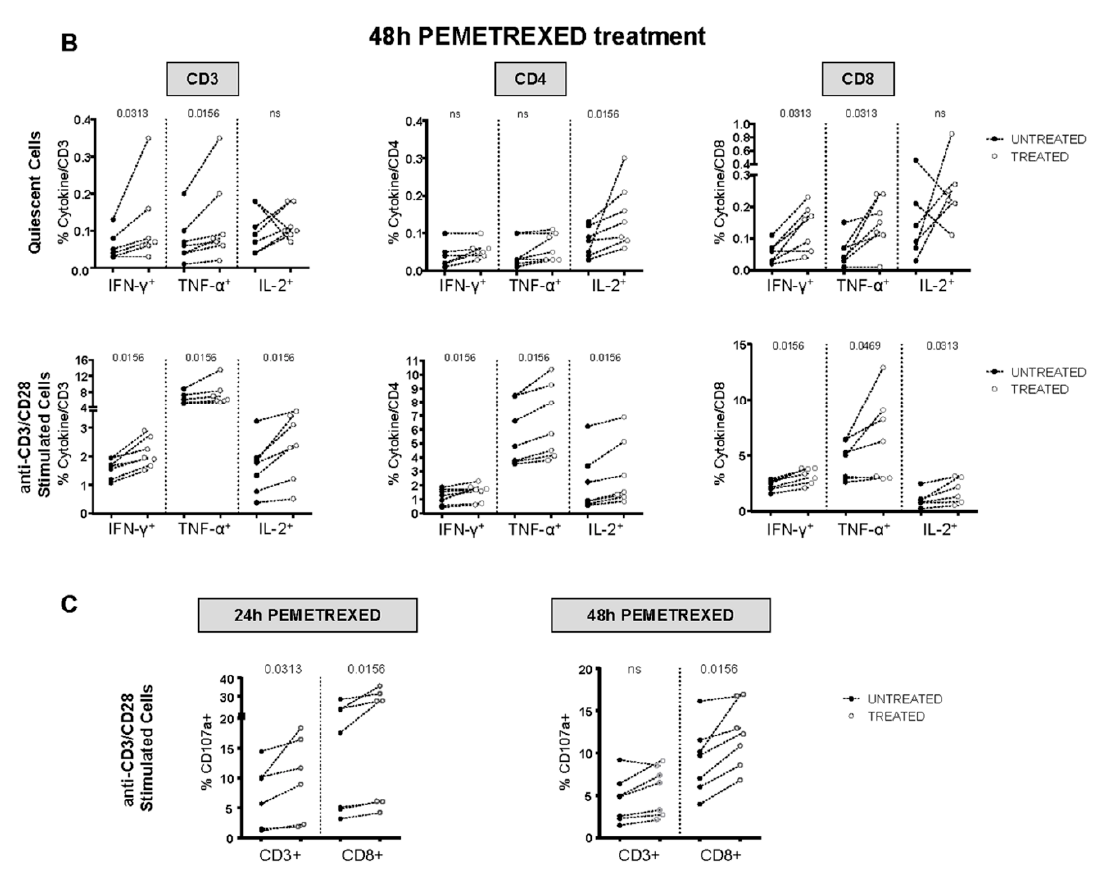
Figure 5. In vitro pemetrexed treatment improved T-cell responses. ( A ) PBMCs from healthy donors ( n = 7) were stimulated for 24 h with anti-CD3 / anti-CD28 antibodies in the presence or absence of 100 nM pemetrexed. This was followed by co-staining for CD3, CD4, or CD8 plus IFN- γ , TNF- α , or IL-2 to determine T-cell function by flow cytometry. Upper and lower plots show results from unstimulated and stimulated PBMCs, respectively, with and without 24 h pemetrexed treatment. Data are presented as cytokine-positive, CD3 +/ CD4 +/ CD8 + T-cells detected in treated and untreated cultures, white and black dots, respectively. ( B ) PBMCs from healthy donors ( n = 7) were stimulated for 48 h as in ( A ). ( C ) PBMCs from healthy donors ( n = 6) were stimulated for 24 and 48 h as in ( A ) together with CD107a antibody to evaluate the cytotoxic potential by flow cytometry. Data are presented as CD107a-positive, CD3 + , and CD8 + T-cells detected in treated and untreated cultures, white and black dots, respectively. ( A – C ) All data were analyzed with the Kolmogorov–Smirnov test to confirm or exclude a normal distribution. A statistical analysis was done by two-tailed Wilcoxon matched-pairs test and p -values are